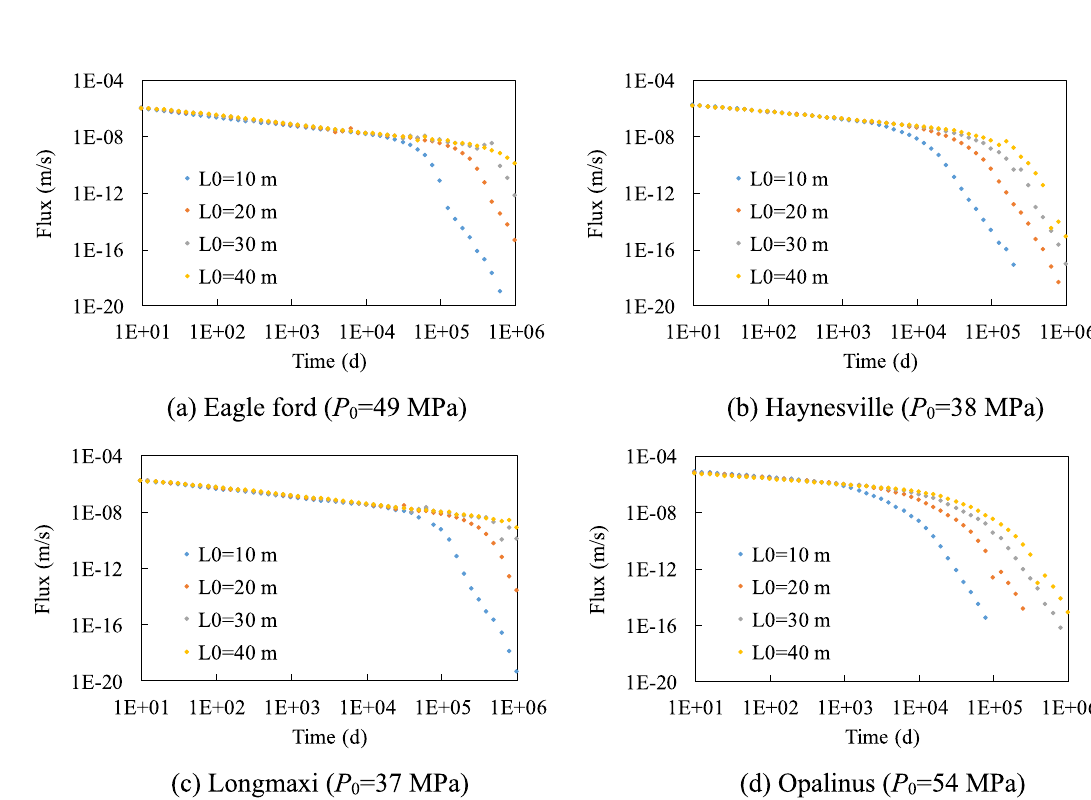
Figure 5. Influence of half fracture length on the gas production